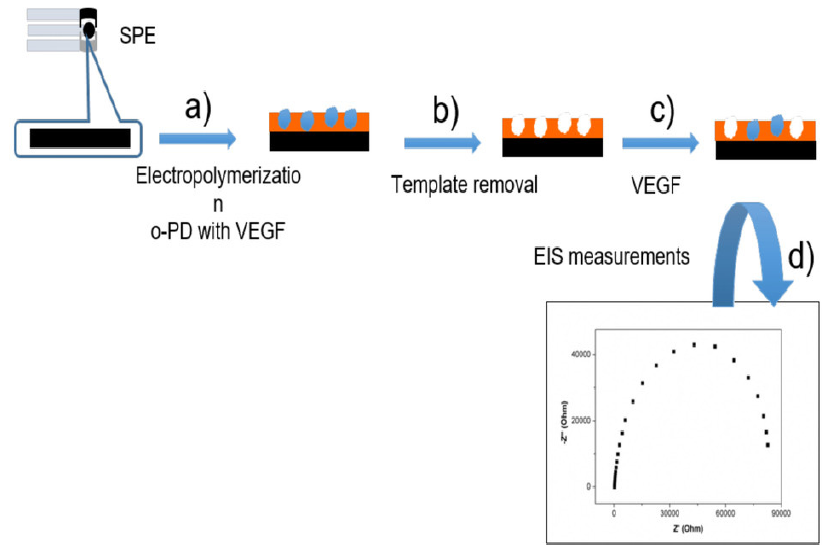
Figure 11. Schematic representation for the process of molecular imprinting (Bozal-Palabiyik et al.) through the electropolymerization of o-phenylenediamine (o-PD) for label-free detection. Reprinted with permission from [146], copyright 2019 Wiley-VCH Verlag GmbH and Co. KGaA, Weinheim.